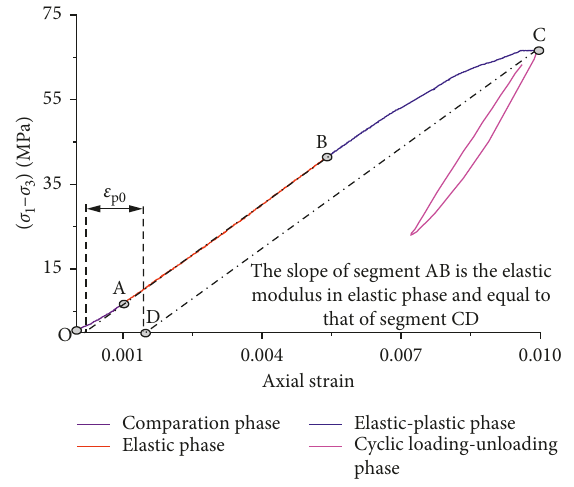
Figure 13: Calculation of the parameter ε